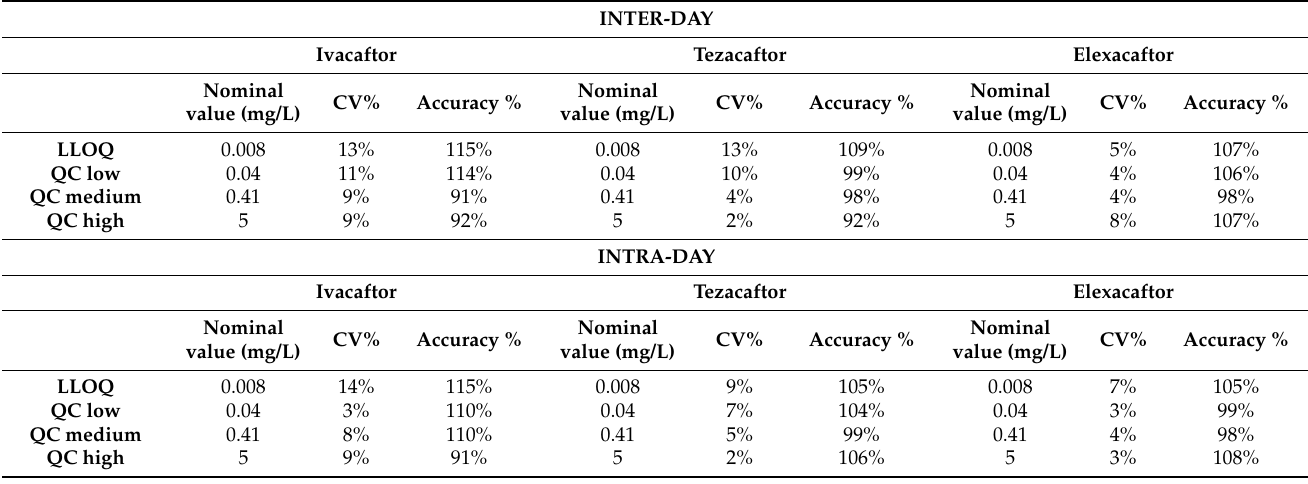
Figure 2. The mean calibration curves in plasma (9-point calibration curve) of ivacaftor ( A ), tezacafor ( B ), and elexacaftor ( C ), ranging from 0.008 to 12 mg/L. Area Ratio, ratio between area standard and IS. Table 2. Results of intra-day and inter-day accuracy and reproducibility assays (n = 5). The quality controls’ concentrations were 0.008, 0.04, 0.41, 5 mg/L for LLOQ, QClow, QC medium, and QC high, respectively (CV% is the coefficient of variation percentage).